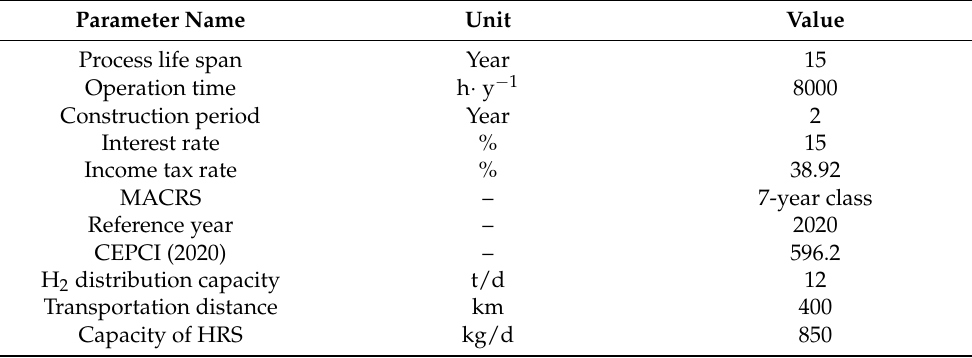
Table 1. Base parameters used for TEA of